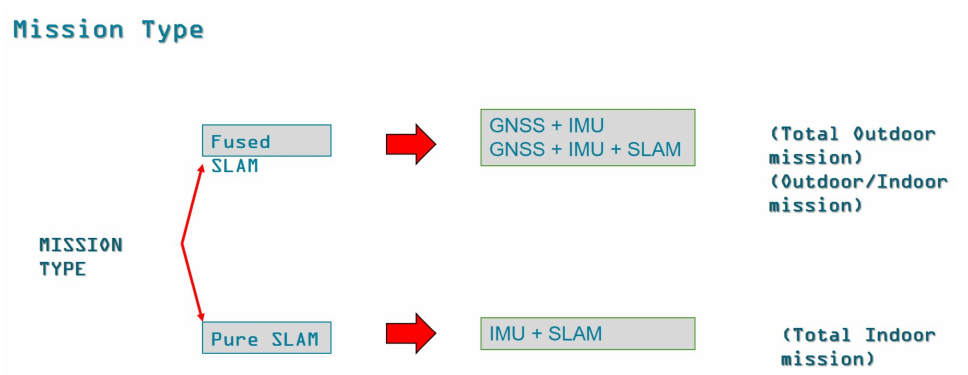
Figure 3. Mission